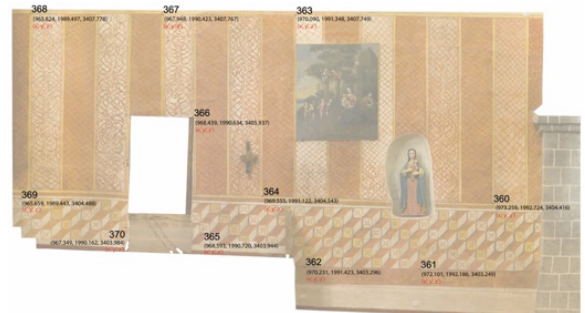
Figure 19 . Ortho-corrected image used as a reference to compare x, y, and z coordinates of GCPs in Scenario